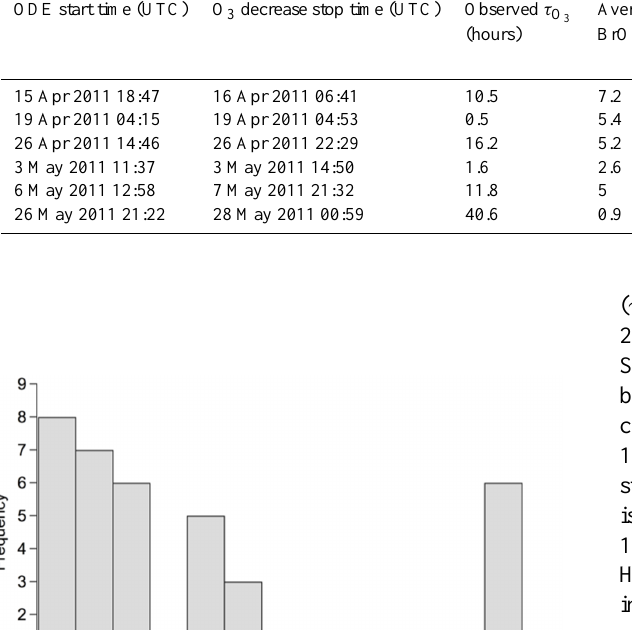
Table 3. Average BrO mole fractions during periods of O 3 decrease from O-Buoy2 MAX-DOAS, the corresponding propagated errors, and the estimated BrO required for the observed O 3 depletion timescales based on Eq. (6) (Sect. 3.1; UTC – Coordinated Universal Time). ODE start time (UTC)